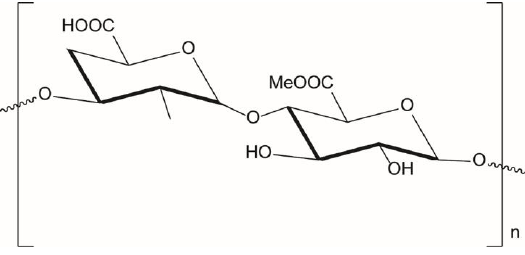
Figure 9. Pectin structure.